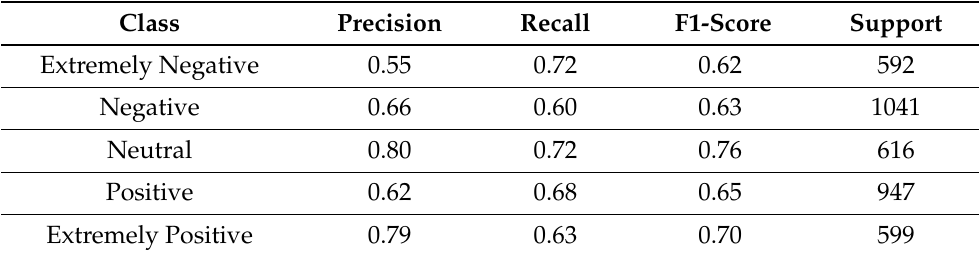
Table 4. Results per class of the LSTM model.